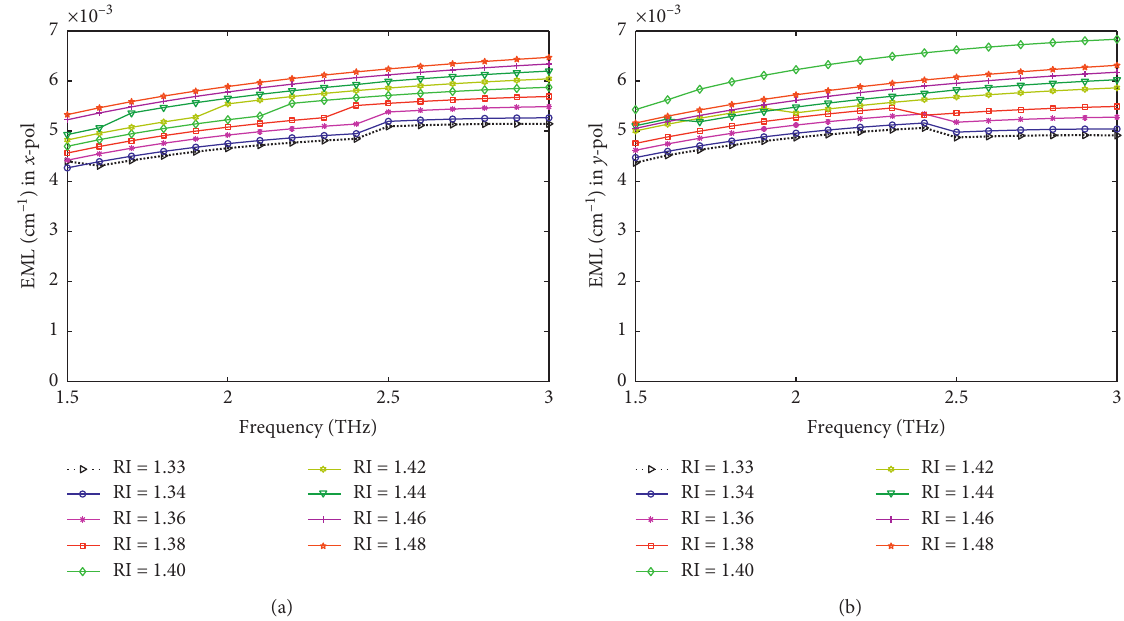
Figure 17: Comparison of the EML of the proposed BCS for different analytes in the THz band. (a) x -PoM and (b) y -PoM.